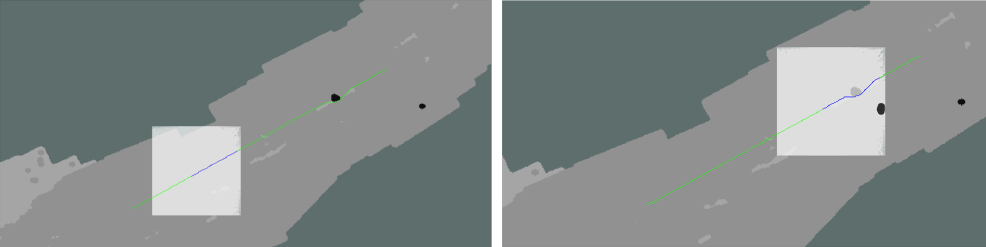
Figure 11. This figure displays the terrain-based cost map, planned ground vehicle path, and local ground-level obstacle map as the vehicle executed the path. The green line shows the planned path of the ground vehicle, while the blue shows the subset of this planned currently being followed. Note the false positive obstacle detected to the right of the planned path. The white square shows the overlaid ground-level obstacle map. Note in the right-hand image, the black circle at the edge of the local cost map does not align with the obstacle as seen from the